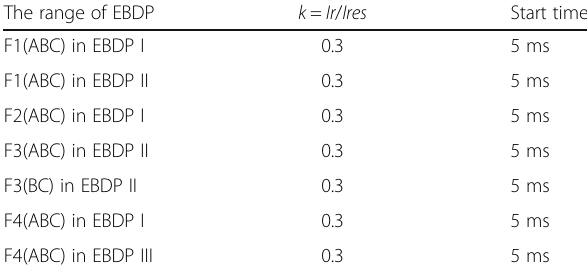
Table 2 Start times of the wide current differential